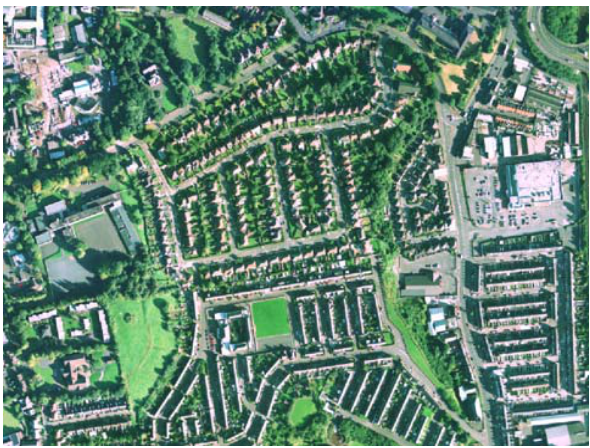
Figure 1a: Micro urban remote sensing. Digital aerial photography at a spatial resolution of 12 cm (Belfast, UK).